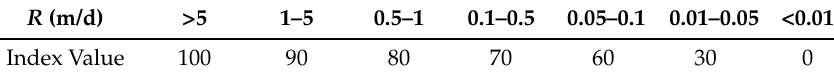
Table 9. Permeability of riverbed layer ( R ) suitability scoring criterion.